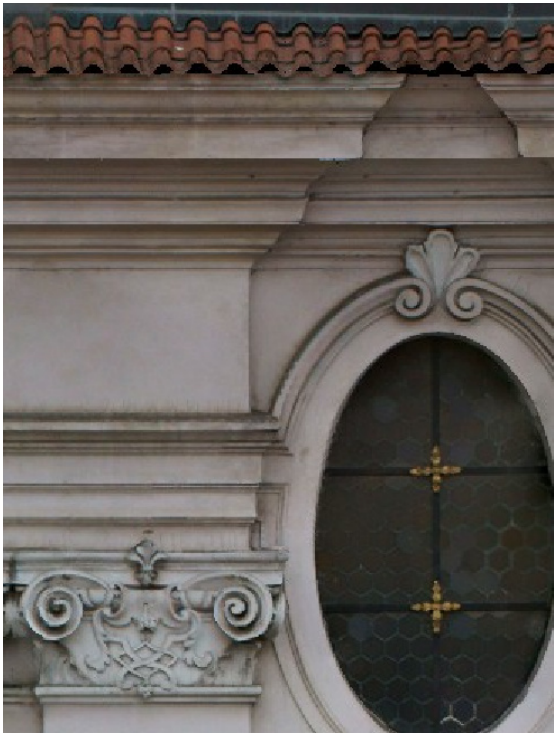
Figure 8. Mosaic orthophoto detail